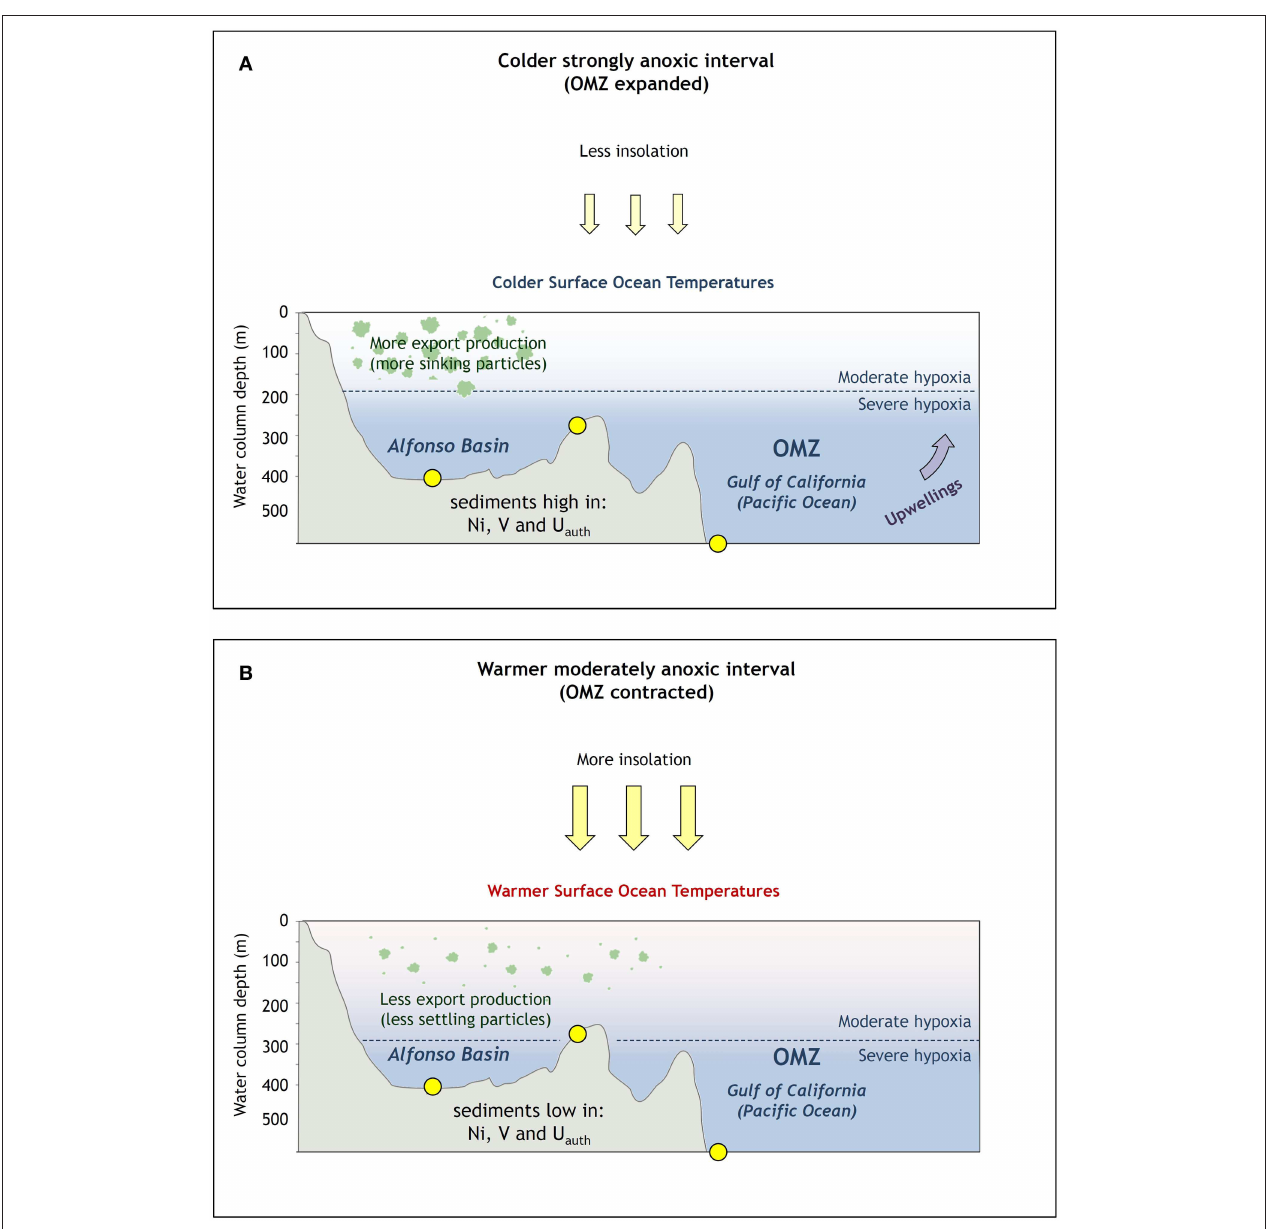
FIGURE 9 | Two dominating oceanographic regimes: (A) high productivity and enhanced anoxia during colder periods, (B) low productivity and reoxygenation during warm